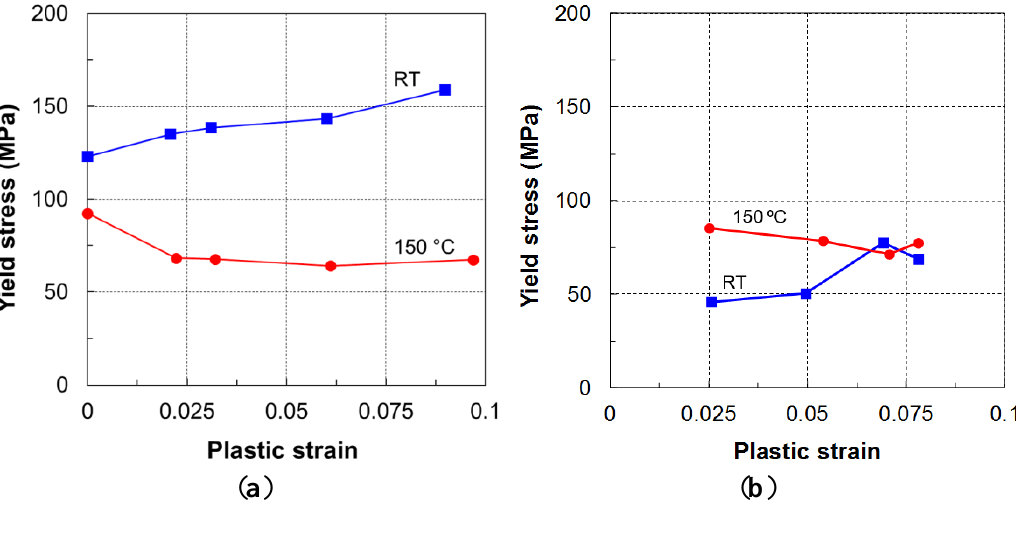
Figure 18. Dependence of yield stress on pre-strains for the isothermal testing cases at room temperature and 150 °C: ( a ) compression loading (twinning deformation mode); and ( b ) tension following compression loading (untwinning deformation